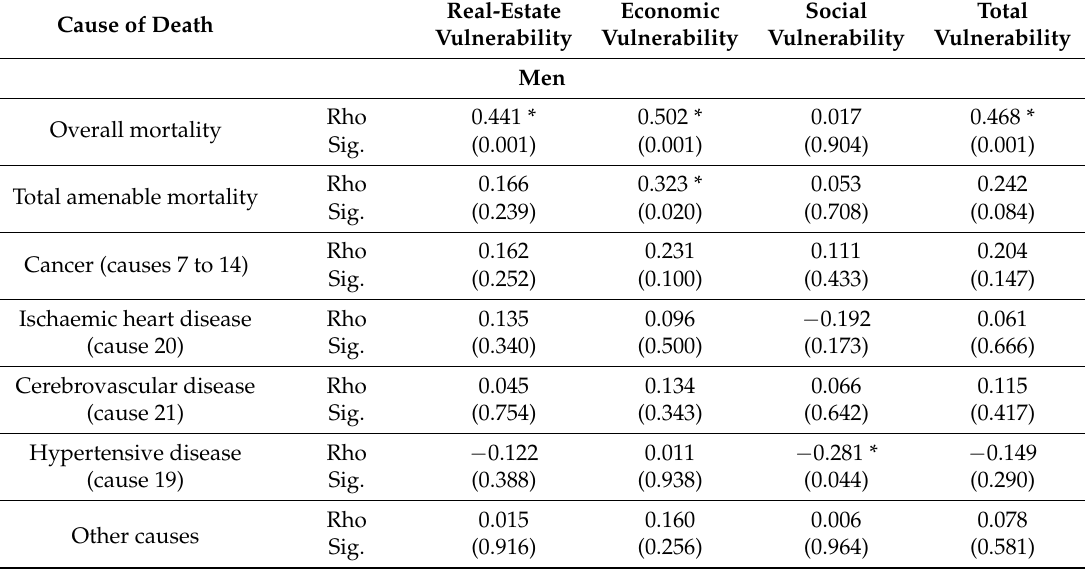
Table 3. Spearman’s rank correlation coefficient $ between the indicators of the impact of the crisis and the relative decreases in overall and amenable